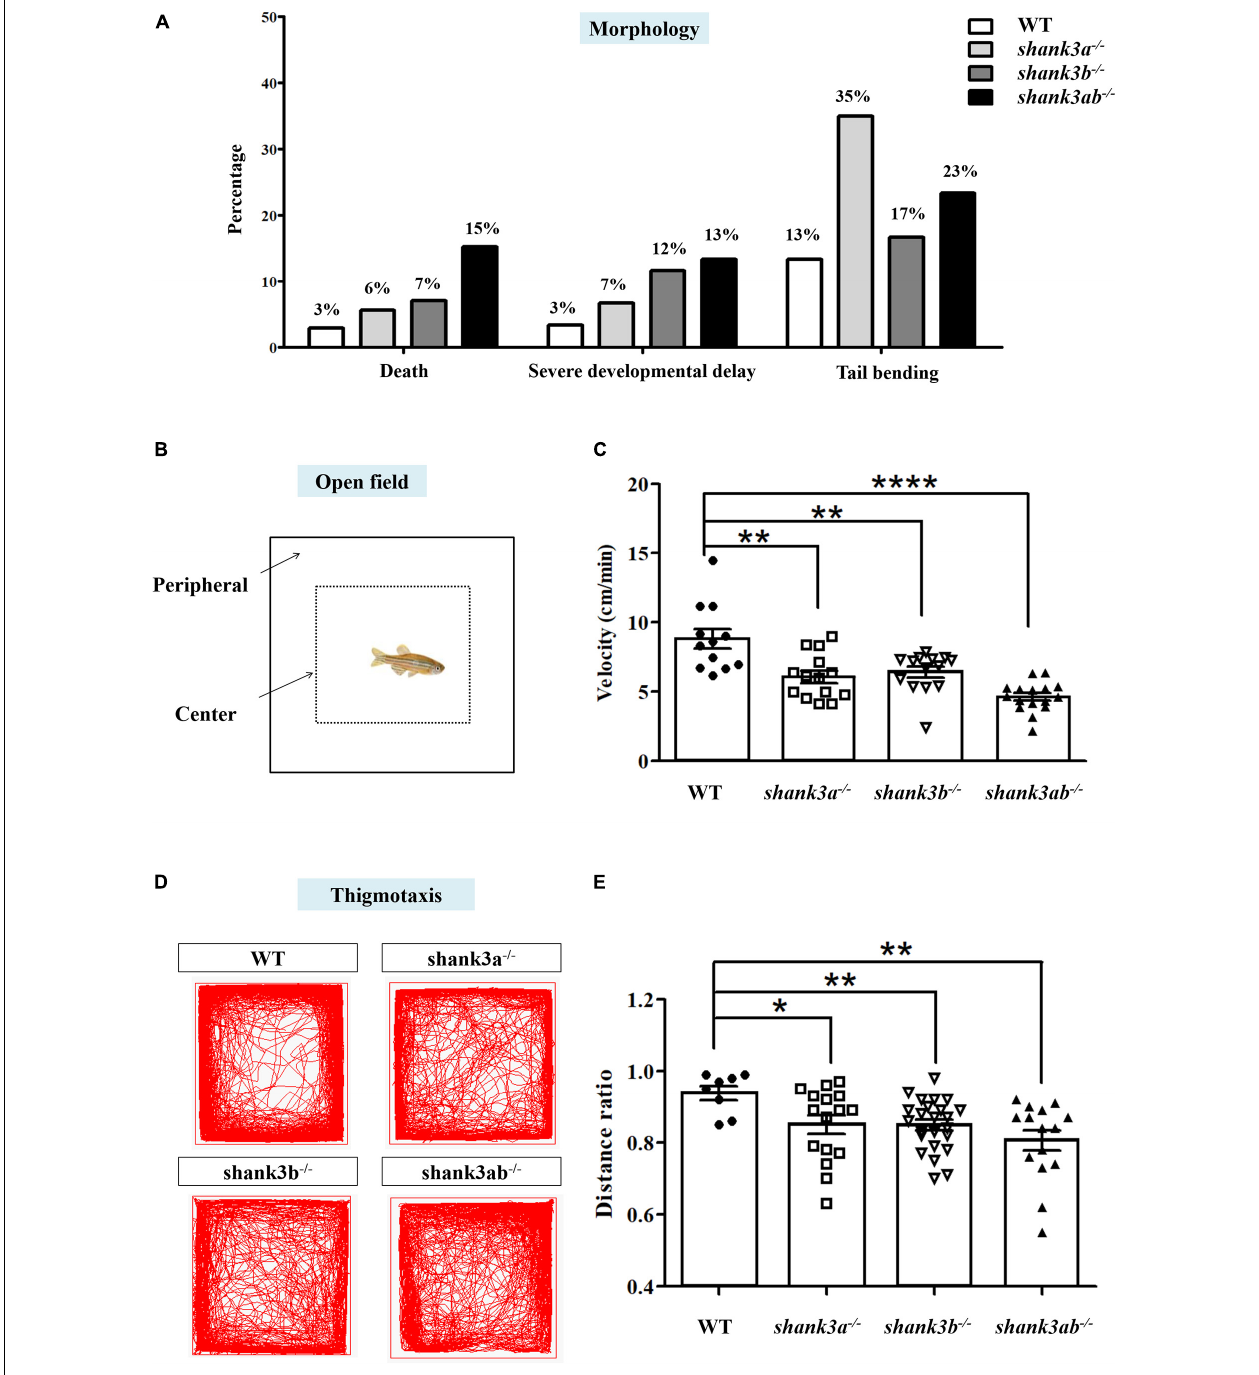
FIGURE 2 | Morphological characteristics and locomotion activity alteration in shank3 -deficient zebrafish. (A) Abnormal morphological changes in shank3a - / - , shank3b - / - , and shank3ab - / - larvae at ∼ 1 dpf, including death (WT, N = 340; shank3a - / - , N = 266; shank3b - / - , N = 270; shank3ab - / - , N = 118, severe developmental delay and tail bending ( N = 60 each group). (B) Schematic diagram of the open field test and thigmotaxis test of adult male zebrafish (3.5 mpf). In the analysis of thigmotaxis test, the area of the peripheral zone is equal to the center zone (dotted line). (C) Compared with WT zebrafish ( N = 12, 8.8 ± 2.4 cm/min), all shank3 -deficient zebrafish displayed significantly decreased swimming velocity ( shank3a - / - , N = 14, 6.1 ± 1.6 cm/min; shank3b - / - , N = 14, 6.4 ± 1.4 cm/min; shank3ab - / - zebrafish, N = 16, 4.6 ± 1.1 cm/min, respectively). (D) Representative traces of individual WT or shank3 -deficient zebrafish in the thigmotaxis test. (E) Ratio for the distance traveled (periphery divided by the total zone) over 30 min in adult male zebrafish (3.5 mpf). WT, N = 8; shank3a - / - , N = 16; shank3b - / - , N = 24; shank3ab - / - zebrafish, N = 15. Data are shown as mean ± SEM; * P < 0.05, ** P < 0.01, *** P < 0.001, **** P < 0.0001.